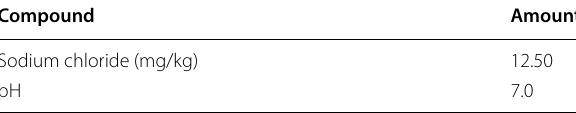
Table 5 Soil chemical properties